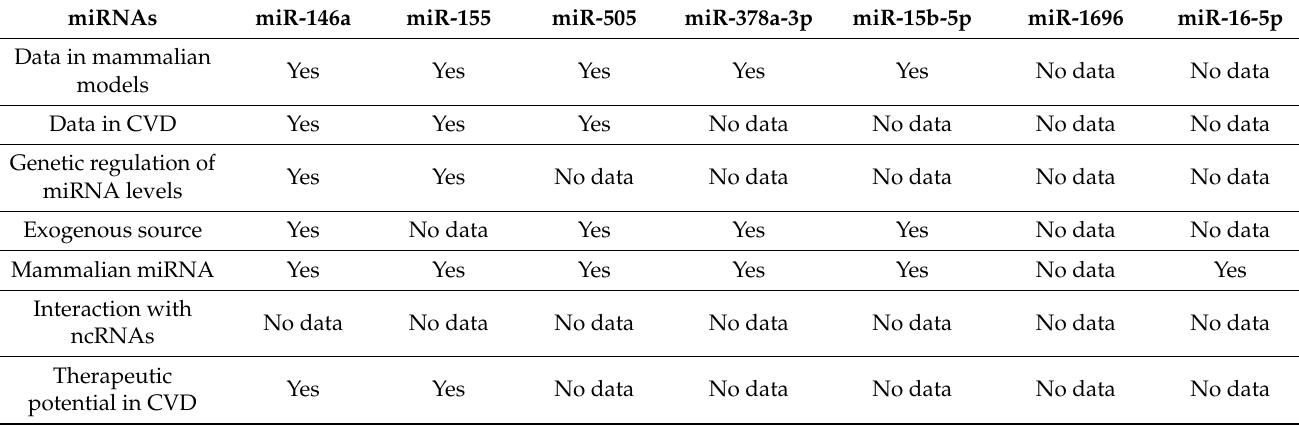
CVD: cardiovascular diseases; ncRNAs: non-coding